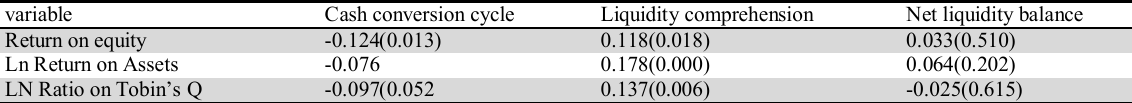
Pearson correlation coefficient among research variables